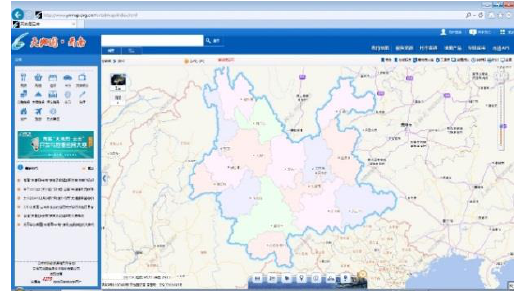
Figure 8. Map World system user